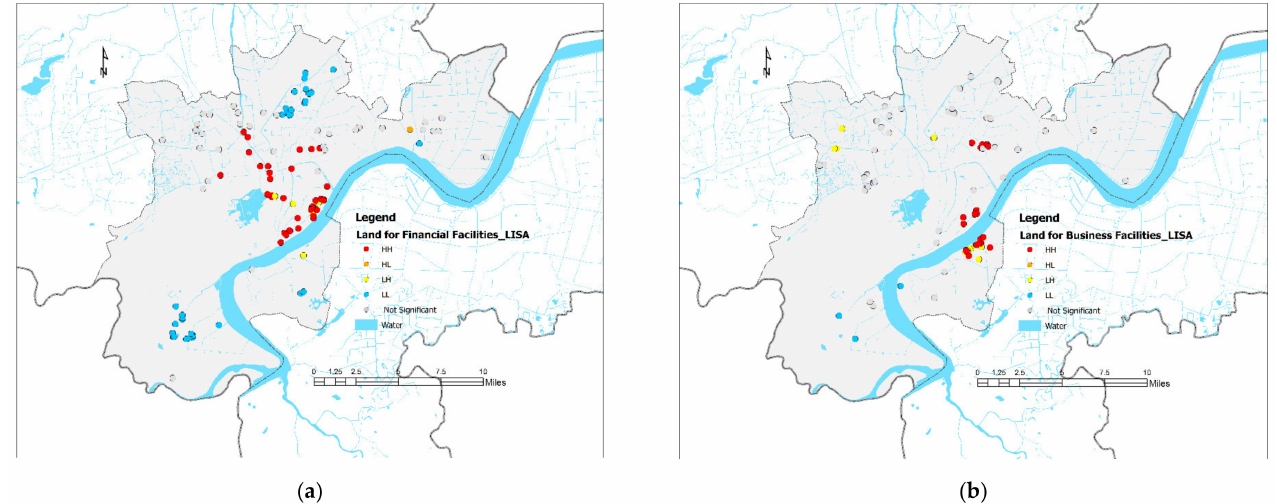
Figure 6. ( a ) LISA scatter map of land for financial facilities (Commercial land category 1) in the main urban area of Hangzhou from 2006 to 2015; ( b ) LISA scatter map of land for business facilities (Commercial land category 2) in the main urban area of Hangzhou from 2006 to